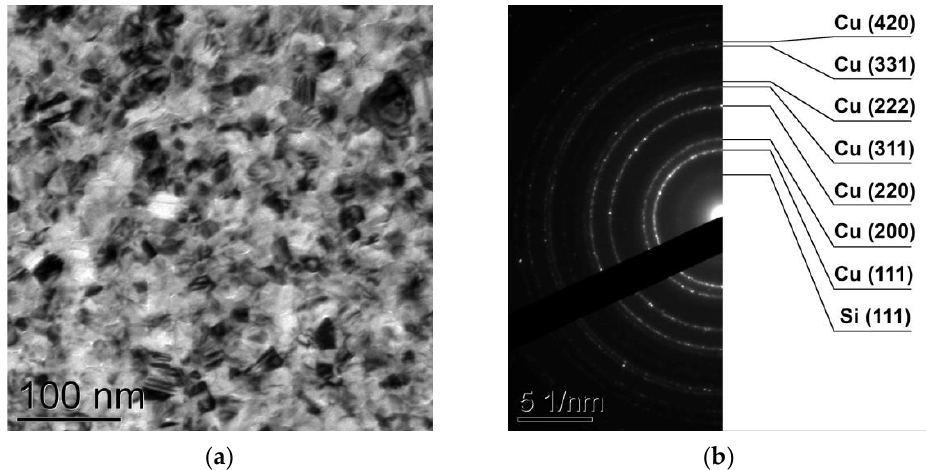
Figure 2. TEM image ( a ) and SAED pattern ( b ) obtained from the Cu/a-Si bilayer thin film at the initial state.